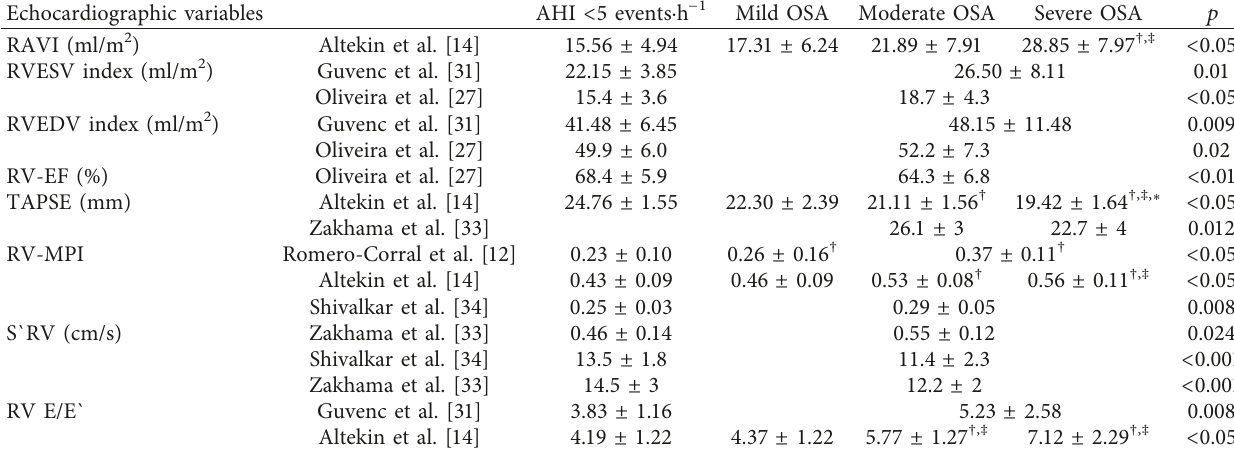
Table 7: Right atrial and ventricular parameters in relationship with